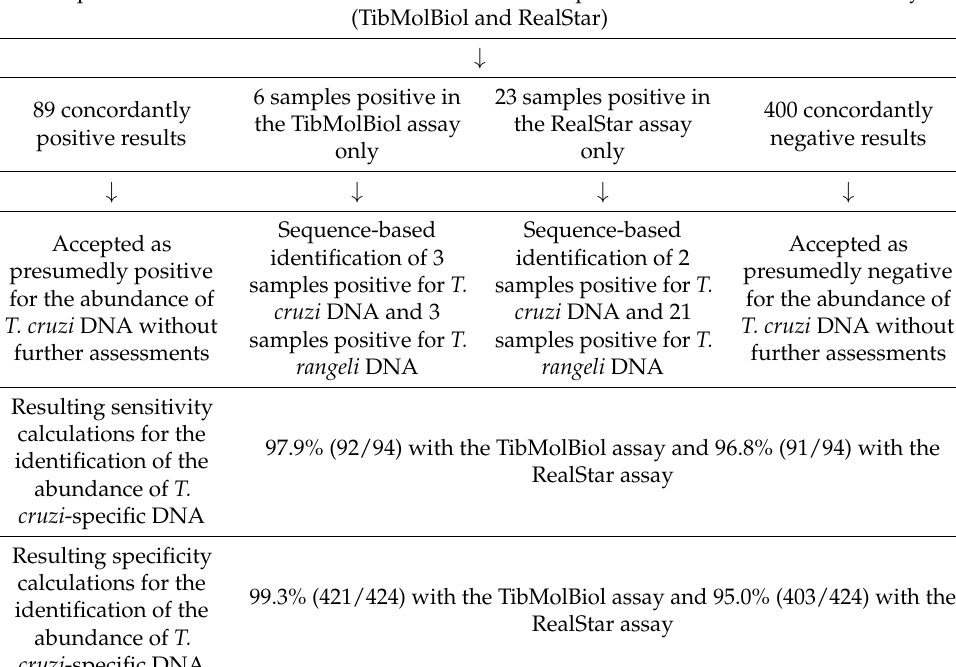
Table 3. Flowchart of the diagnostic results and their interpretation. Comparative assessment of 518 consecutive serum samples with both real-time PCR